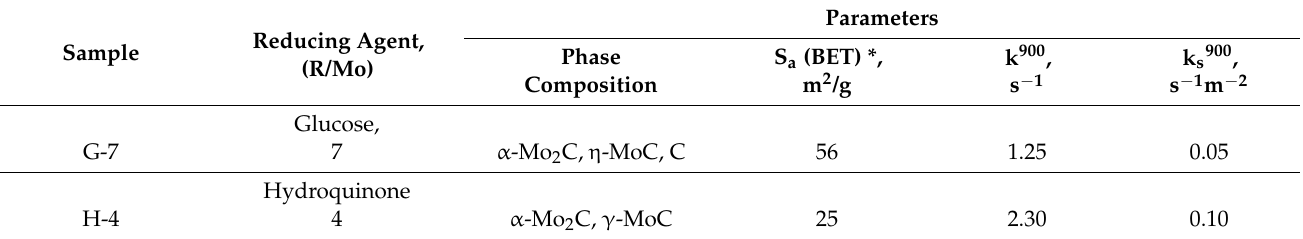
Table 2. Catalytic activity of Mo 2 C synthesized from molybdenum blue xerogels using glucose (R/Mo = 7) and hydroquinone (R/Mo = 4). Sample